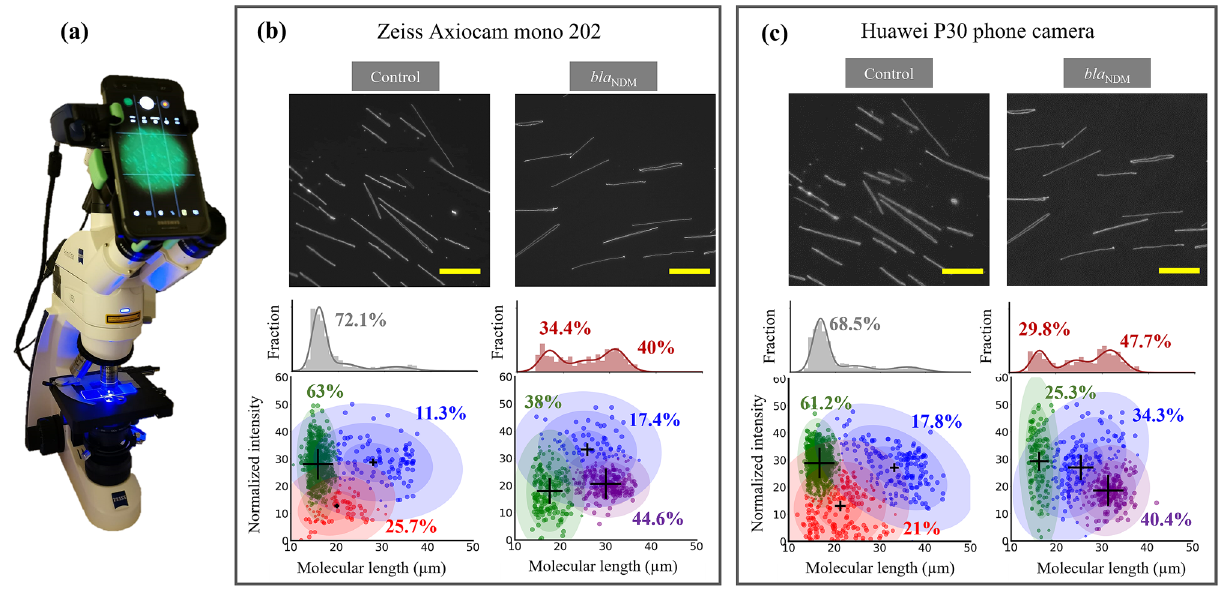
Figure 4. Use of a simple fluorescence microscope and smartphone camera for carbapenemase gene detection. ( a ) Zeiss PrimoStar iLED microscope equipped with Axiocam mono-202 and Huawei P30 smartphone camera was used to image plasmids stretched on glass. ( b ) DNA images for the control and bla NDM reactions captured using the Axiocam mono-202 camera (top) and the corresponding length histograms (middle) and cluster plots (bottom). ( c ) DNA images and data analysis for images acquired for the sample using the Huawei P30 smartphone camera. Images shown are acquired from the same location on the coverslip. The population clusters identified by the algorithm are presented in different colors. The mean values are marked with ‘ + ’ signs (scaled to the weights of the clusters). The percentage values represent the percentage of the population in that cluster. The colored ellipses represent the standard deviations of the mean. Scale bars:20